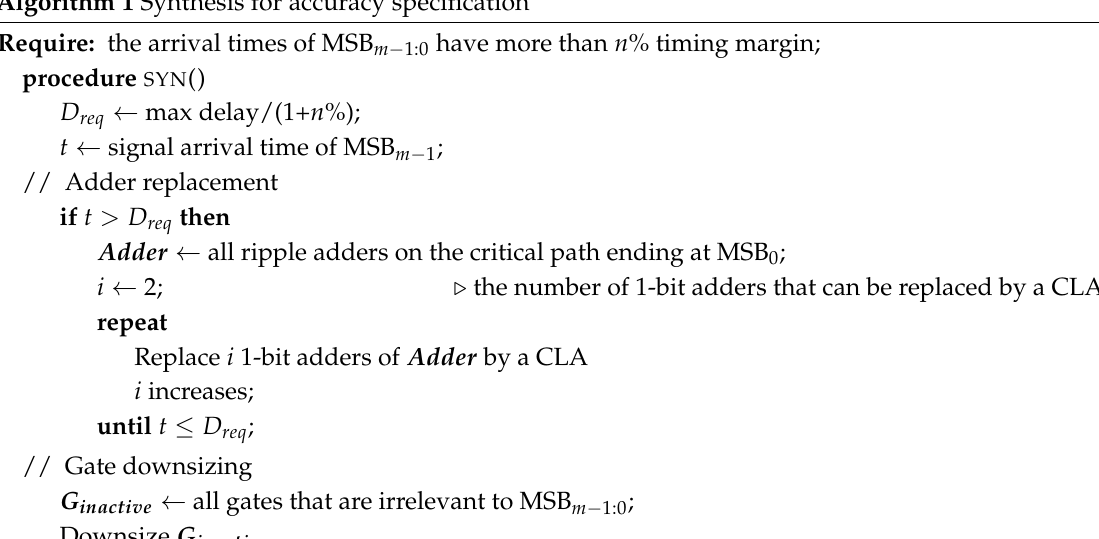
Algorithm 1 Synthesis for accuracy